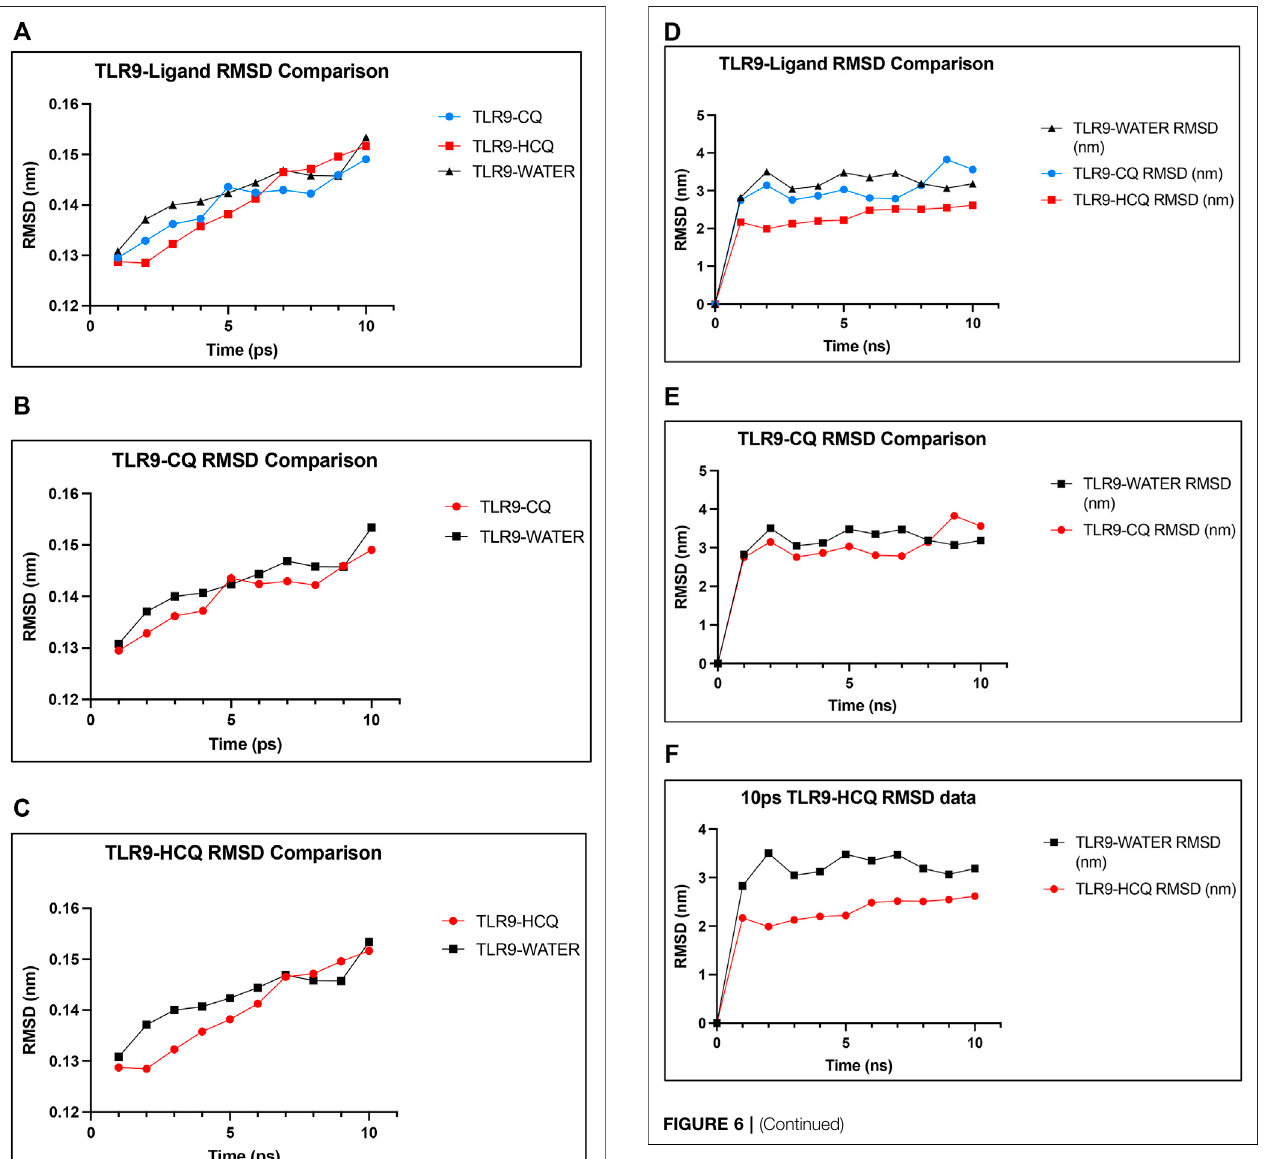
indicates lower stability of the protein complex in the given simulation conditions (Das et al., 2021a; Das et al., 2021b).